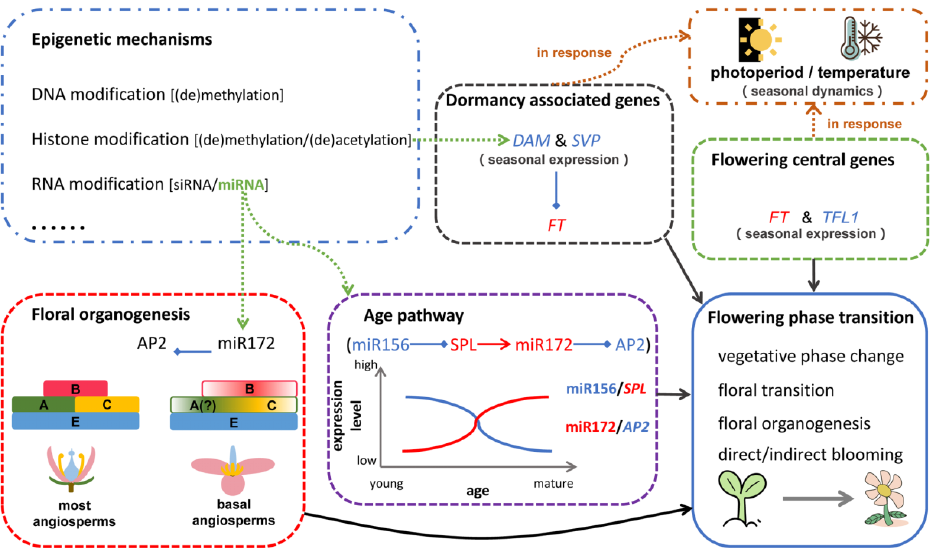
Figure 2. Diagram illustrating the molecular model underlying flowering regulation in perennial trees, which incorporates important/central genes and microRNAs as well as epigenetic modification. Black solid arrows indicate gene regulation; green dotted arrows indicate epigenetic modification participating in gene regulatory modules; brown dotted arrows represent responses to environmental cues.